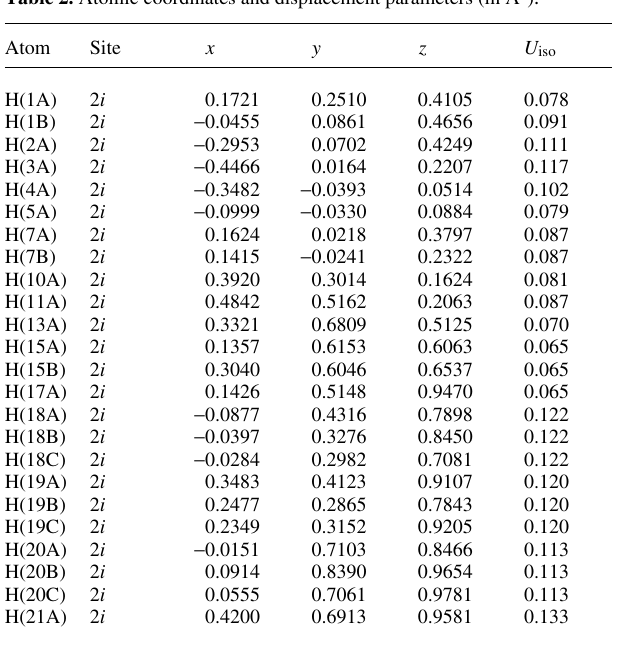
Table 2. Atomic coordinates and displacement parameters (in Å 2 )